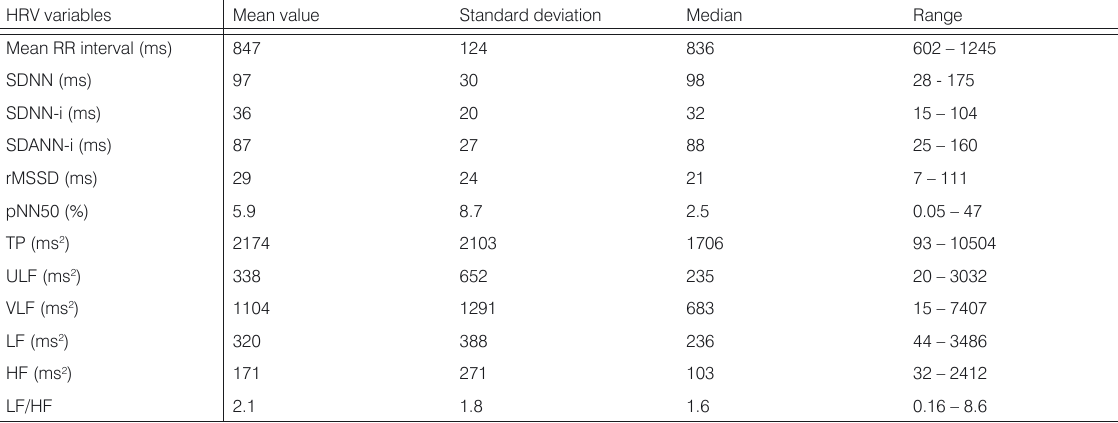
Mean RR - mean of R-R intervals for normal beats, SDNN - standard deviation of all normal R-R intervals, SDANN-i - standard deviation of the 5-minute means of R-R intervals, SDNN-i - mean of the 5-minute standard deviations of RR intervals, rMSSD - square root of the mean of the squared successive differences in R-R intervals and pNN50 - percentage of R-R intervals that are at least 50 ms different from the previous interval, TP - Total power (0.0-0.5 Hz), VLF - very low (0.003-0.04 Hz), LF - low (0.04-0.15 Hz) and HF - high (0.15-0.4 Hz) frequency components, LF/HF - low to high frequency